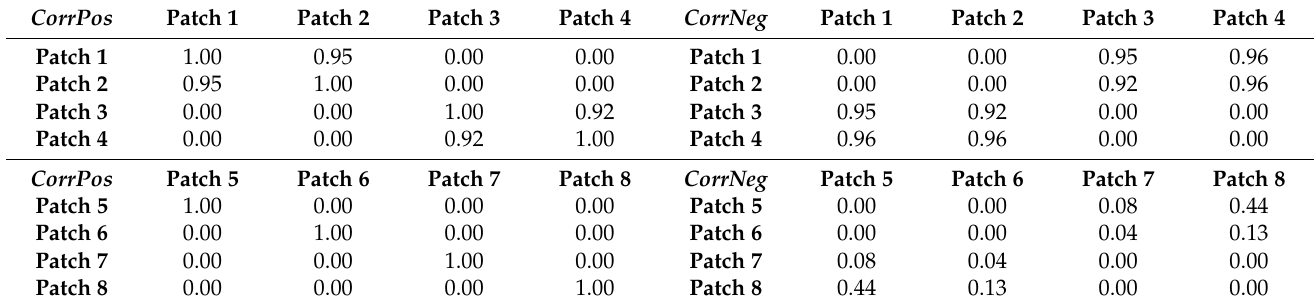
Figure A3. Spatial textures of patches with high or low correlation coefficients. Table A3. Part of the correlation coefficients between patches presented in Figure A3.